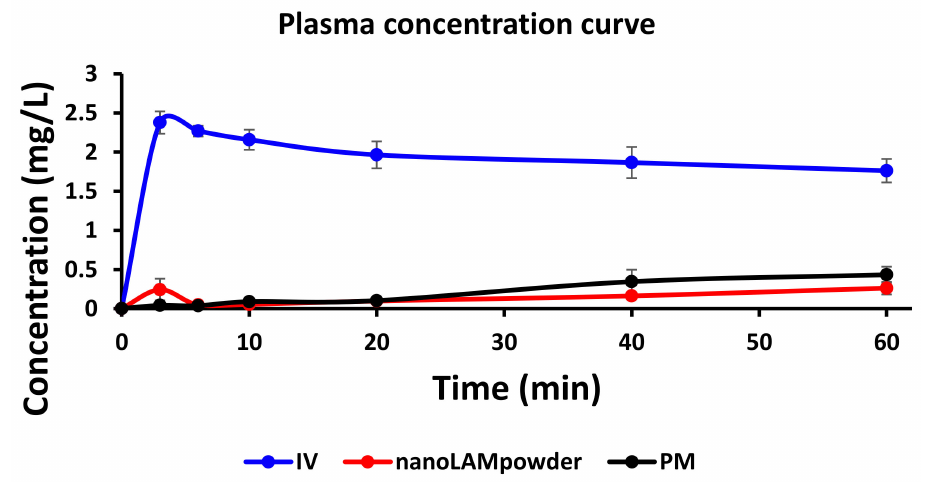
Figure 6. The concentration values of lamotrigine (LAM) in the blood plasma in the case of IV and intranasal